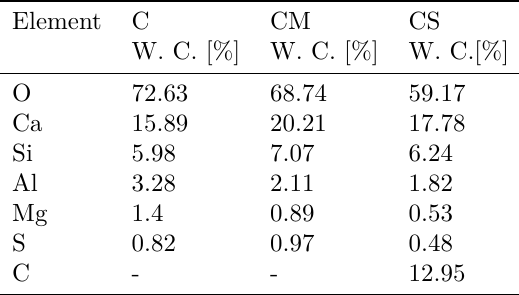
Table 2. Weight concentrations of